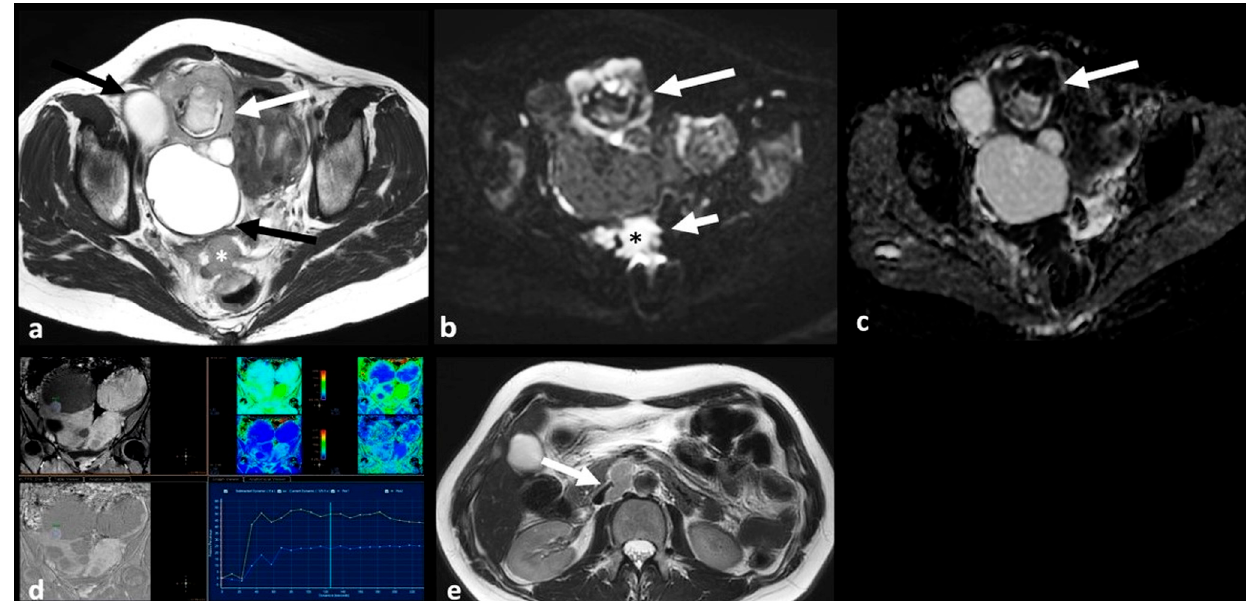
Figure 3. High grade serous cystadenocarcinoma with peritoneal and lymph node metastases. Axial T2 weighted image ( a ) shows a multiloculated right ovarian cystic mass (black arrows) with a large solid component (white arrow). The solid portion (white arrow) demonstrates high signal on axial 1200 b value DWI ( b ) and low signal on ADC map ( c ). DCE image analysis ( d ) demonstrates an intermediate-risk time intensity curve of the solid tissue (TIC type 2, orange line: myometrium, blue line: solid tissue). Axial T2 weighted image of the upper abdomen of the same patient ( e ) shows right paraaortic lymphadenopathy (white arrow). Shown also is a large peritoneal implant in the pelvis (asterisk in ( a ); asterisk and short arrow in ( b )).